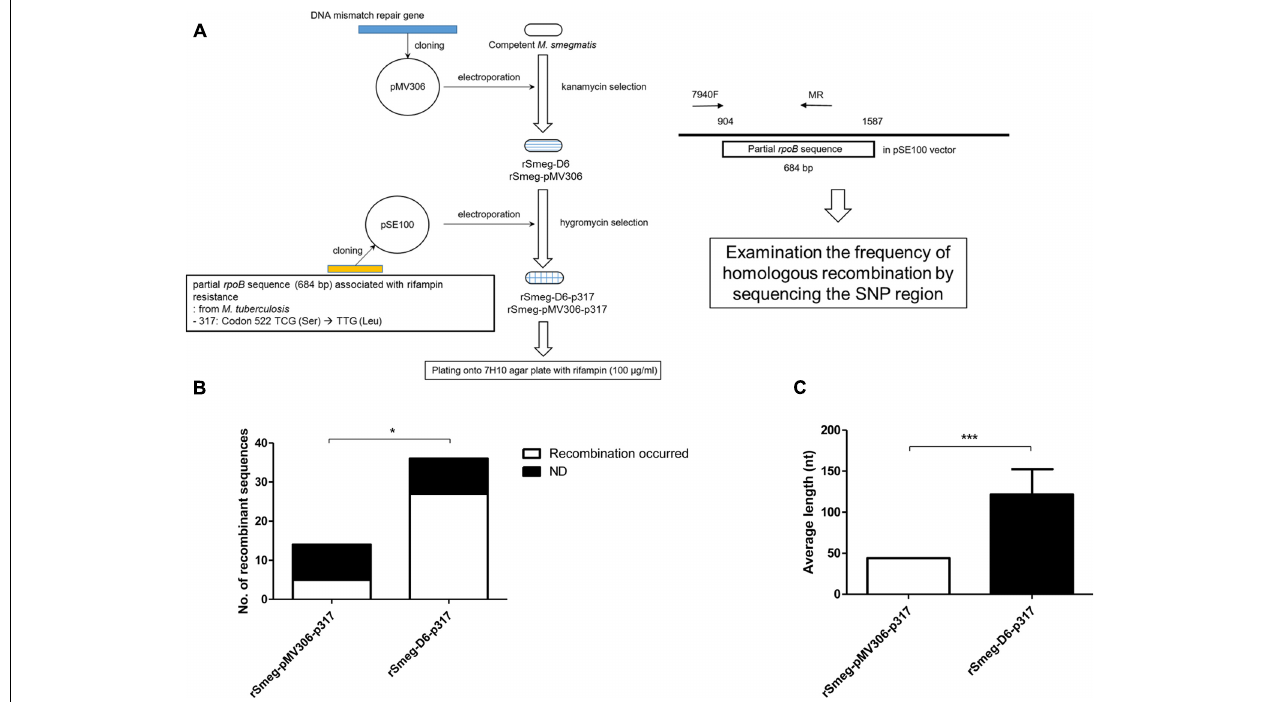
FIGURE 5 | Analysis the putative homologous recombination event in recombinant M. smegmatis harboring DNA mismatch repair genes and partial rpoB gene of M. tuberculosis . (A) Schematic flow for analyzing frequency of homologous recombination using recombinant M. smegmatis harboring DNA mismatch repair genes and partial rpoB gene of M. tuberculosis . (B) Comparison the numbers of putative homologous recombined rpoB sequences in the transformed recombinant strains which were grown on 7H10 agar plate supplemented with rifampin. From the transformed colonies, partial rpoB was analyzed whether the sequence was recombined with rifampin resistant M. tuberculosis partial rpoB gene sequence. ND means the colonies where recombination has not been occurred. P -value was calculated by Chi-square test. ∗ P < 0.05. (C) Comparison the average length of putative homologous recombined sequences in the transformed recombinant M. smegmatis strains. P -value was calculated by student’s- t test. ∗∗∗ P <